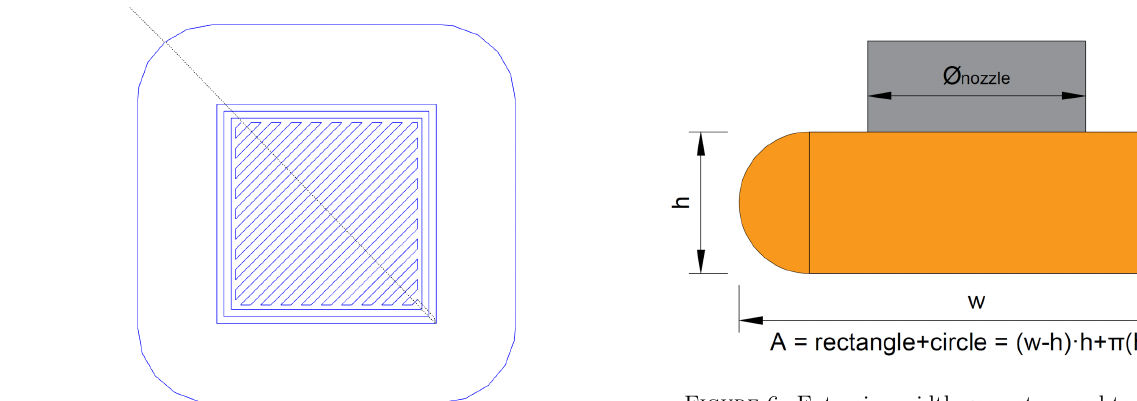
Figure 6. Extrusion width geometry used to produce G-code in Slic3r software